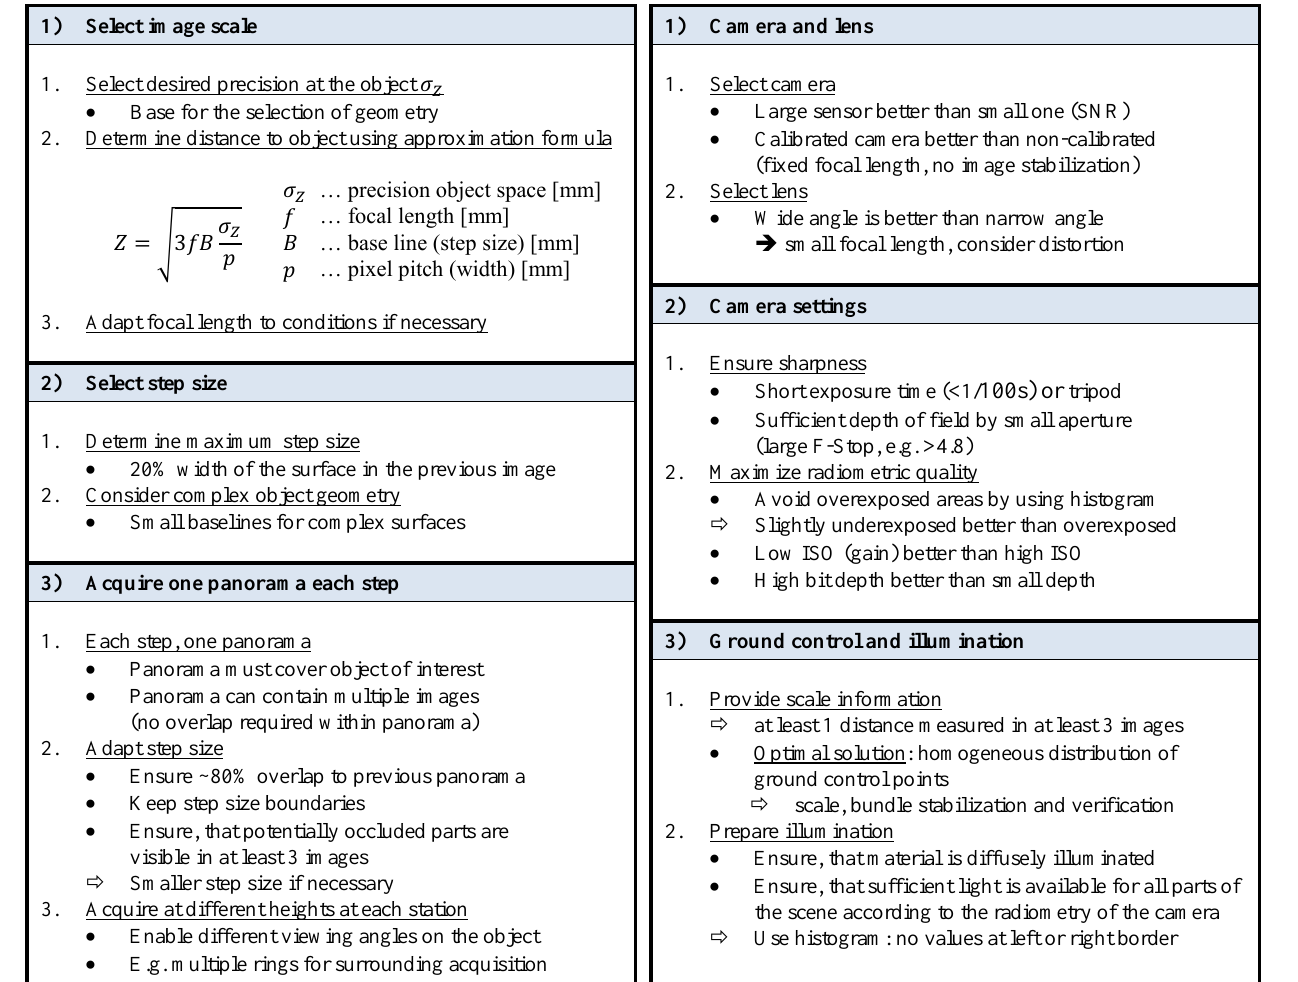
Table 4: Summary general settings